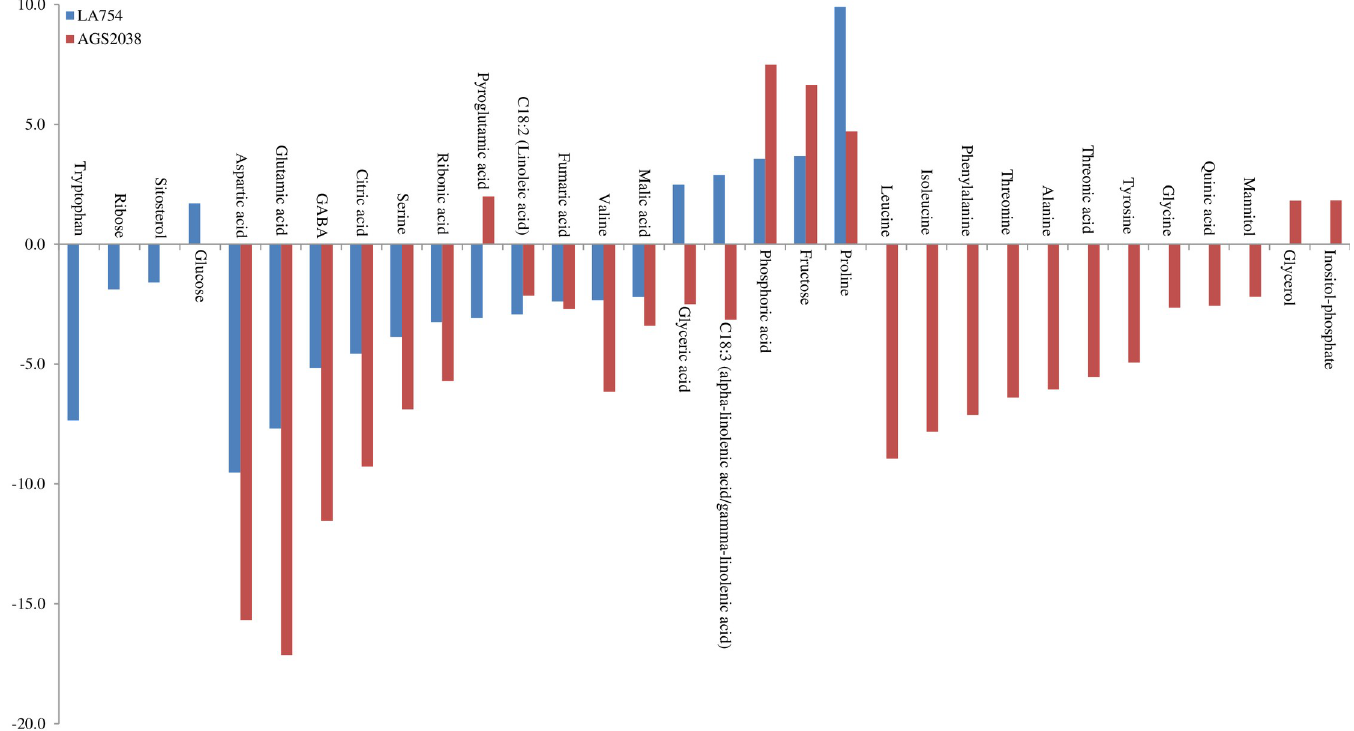
Fig 9. Metabolites of the absolute value of fold change (Drought/Control) were more than 1.5 in